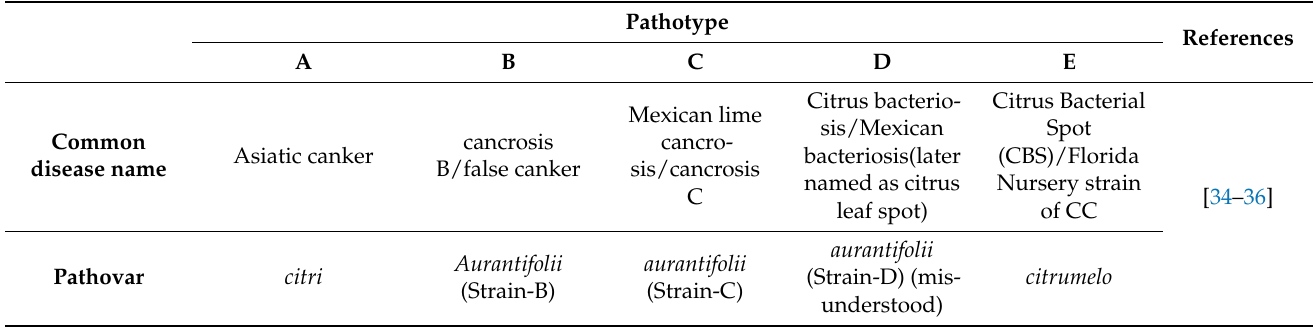
Table 1. Comparison of